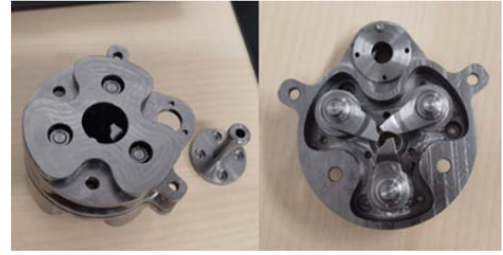
Figure 20. Prototype assembly.